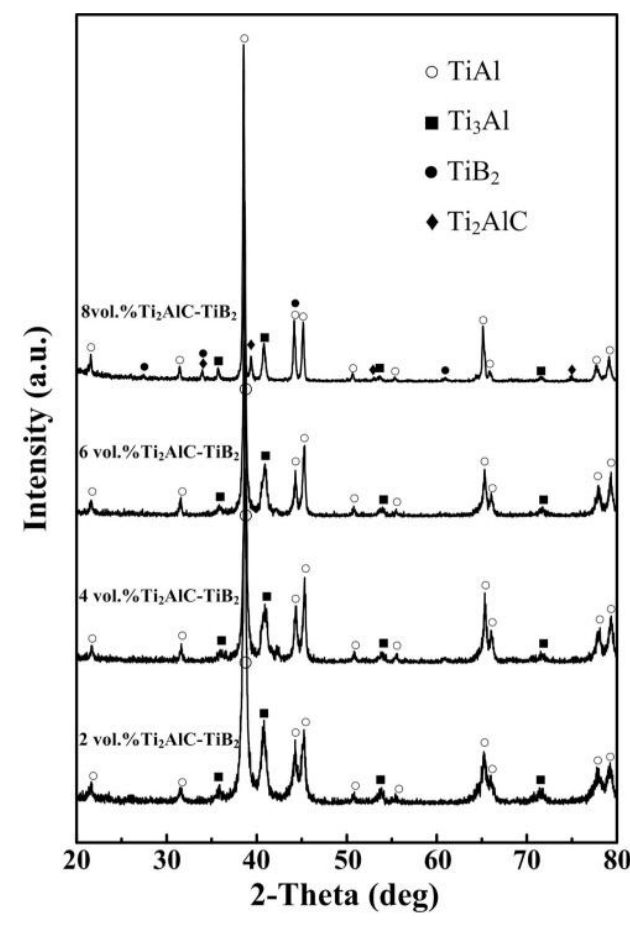
Figure 1. XRD patterns of in situ dual reinforcement TiB 2 -Ti 2 AlC/TiAl composites fabricated by using the Ti-Al-B 4 C